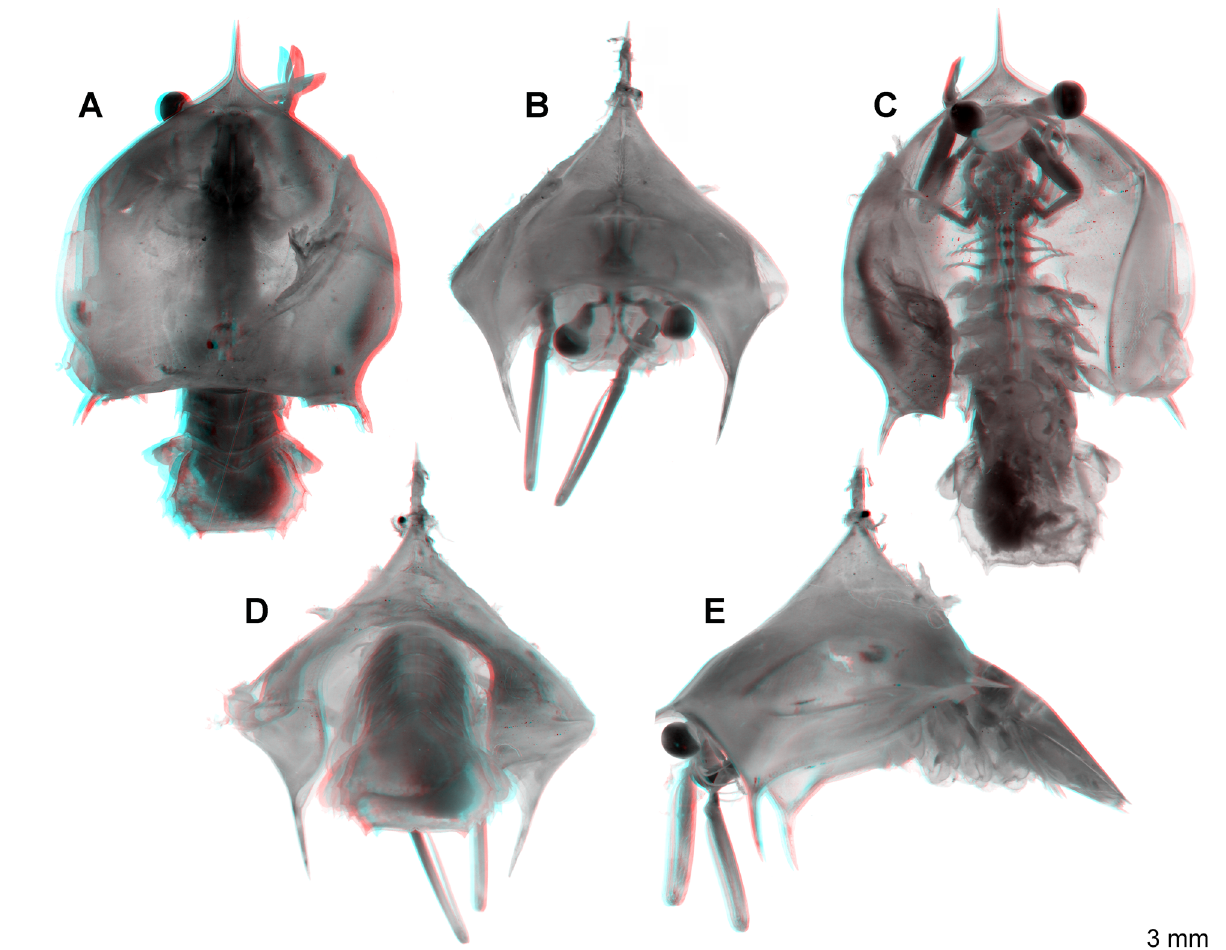
Figure 3. New morphotype 5, “spiked helmet”, specimen 30023A, stereo images. A. Dorsal view. B. Anterior view. C. Ventral view. D. Posterior view. E. Lateral view on left side. All images are red-cyan stereo-anaglyphs, please use red-cyan glasses to